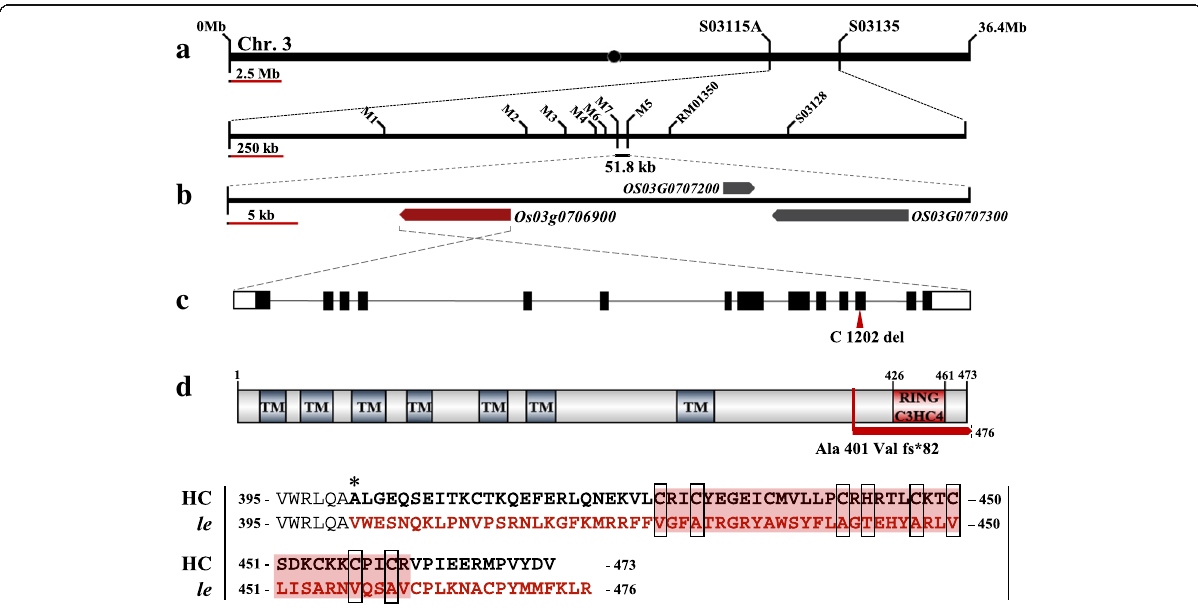
Fig. 4 Map based cloning of the LE gene. a Schematic diagram of mapping of LE locus. b Candidate ORFs in delimited candidate region. c LE gene structure and splicing pattern. Black lines, white solid boxes, and black solid boxes indicate intron, UTRs, and exons, respectively. The mutation position is marked with red arrow head. d LE protein structure and comparison of amino acid sequence of the frameshift region between the HC and le mutant. Asterisk represents the location of amino acid substitution caused by one base deletion in le mutant. Amino acids in the region of frameshift (fs) are indicated in red. Red background and black open boxes indicate amino acid sequences of RING C3HC4 domain and conserved residues in the